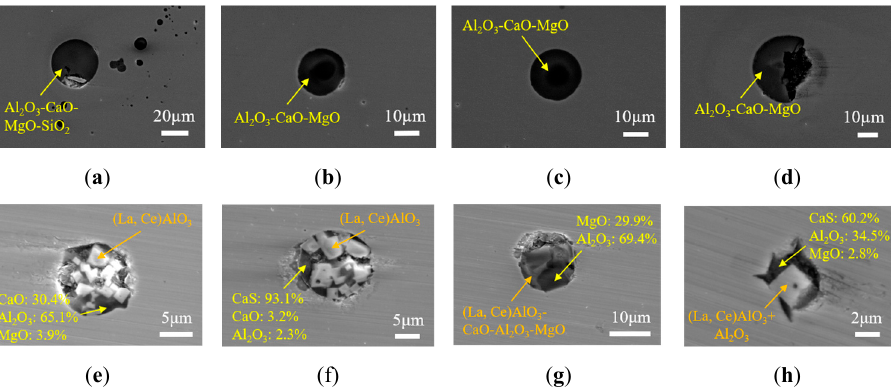
Figure 11. Morphologies and compositions of typical inclusions in the steel, before and after rare earth treatment, after the RH refining station. ( a ) Al 2 O 3 -CaO; ( b ) Al 2 O 3 -SiO 2 -MnS-CaS; ( c ) Al 2 O 3 -CaO-CaS; ( d ) Al 2 O 3 -CaO; ( e ) (La,Ce)AlO 3+ Al 2 O 3 -MgO-CaS-SiO 2 ; ( f ) (La,Ce)AlO 3- Al 2 O 3 +Al 2 O 3 -MgO-CaO; ( g ) (La,Ce)AlO 3 +Al 2 O 3 -MgO-CaS-SiO 2 ; ( h ) (La,Ce)AlO 3+ Al 2 O 3 -MgO-CaS-CaO.